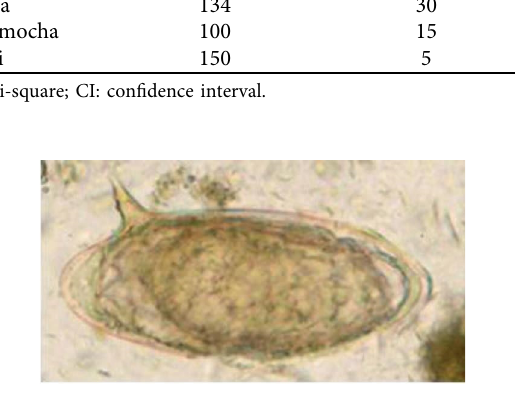
Table 1: Prevalence of bovine schistosomiasis based on the study area (origin) risk factors. Study area